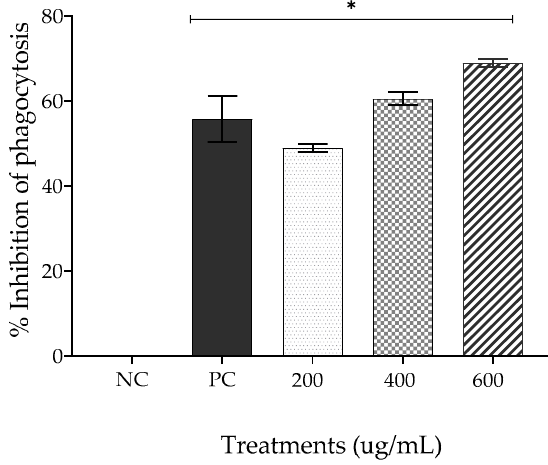
Figure 4. Mean ± SD of the percentage inhibition of phagocytosis for each treatment group: negative control (NC; physiologic solution 0.9%), positive control (PC; 100 µ g/mL, dexamethasone), and EPPR (200 µ g/mL, 400 µ g/mL, and 600 µ g/mL). The asterisk (*) indicates a significant difference ( p < 0.05) compared with the NC. One-way ANOVA followed by Tukey’s post hoc test.